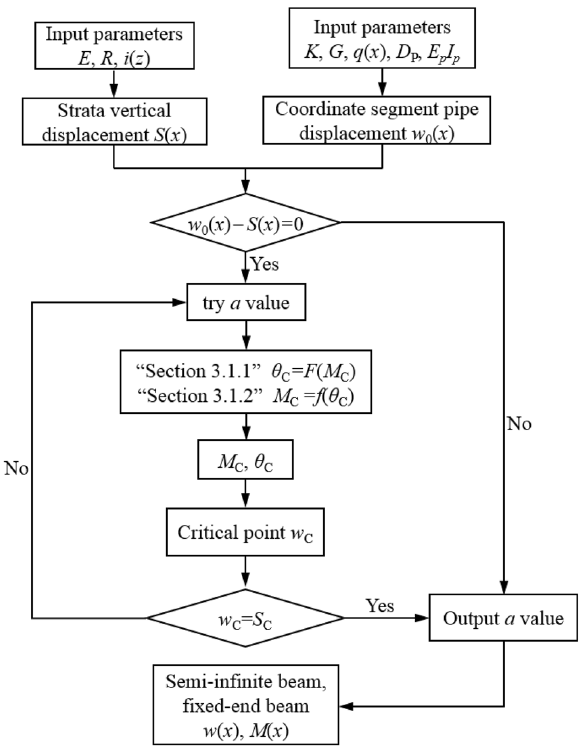
Figure 7. Flow chart for calculation of the range of pipeline-soil void